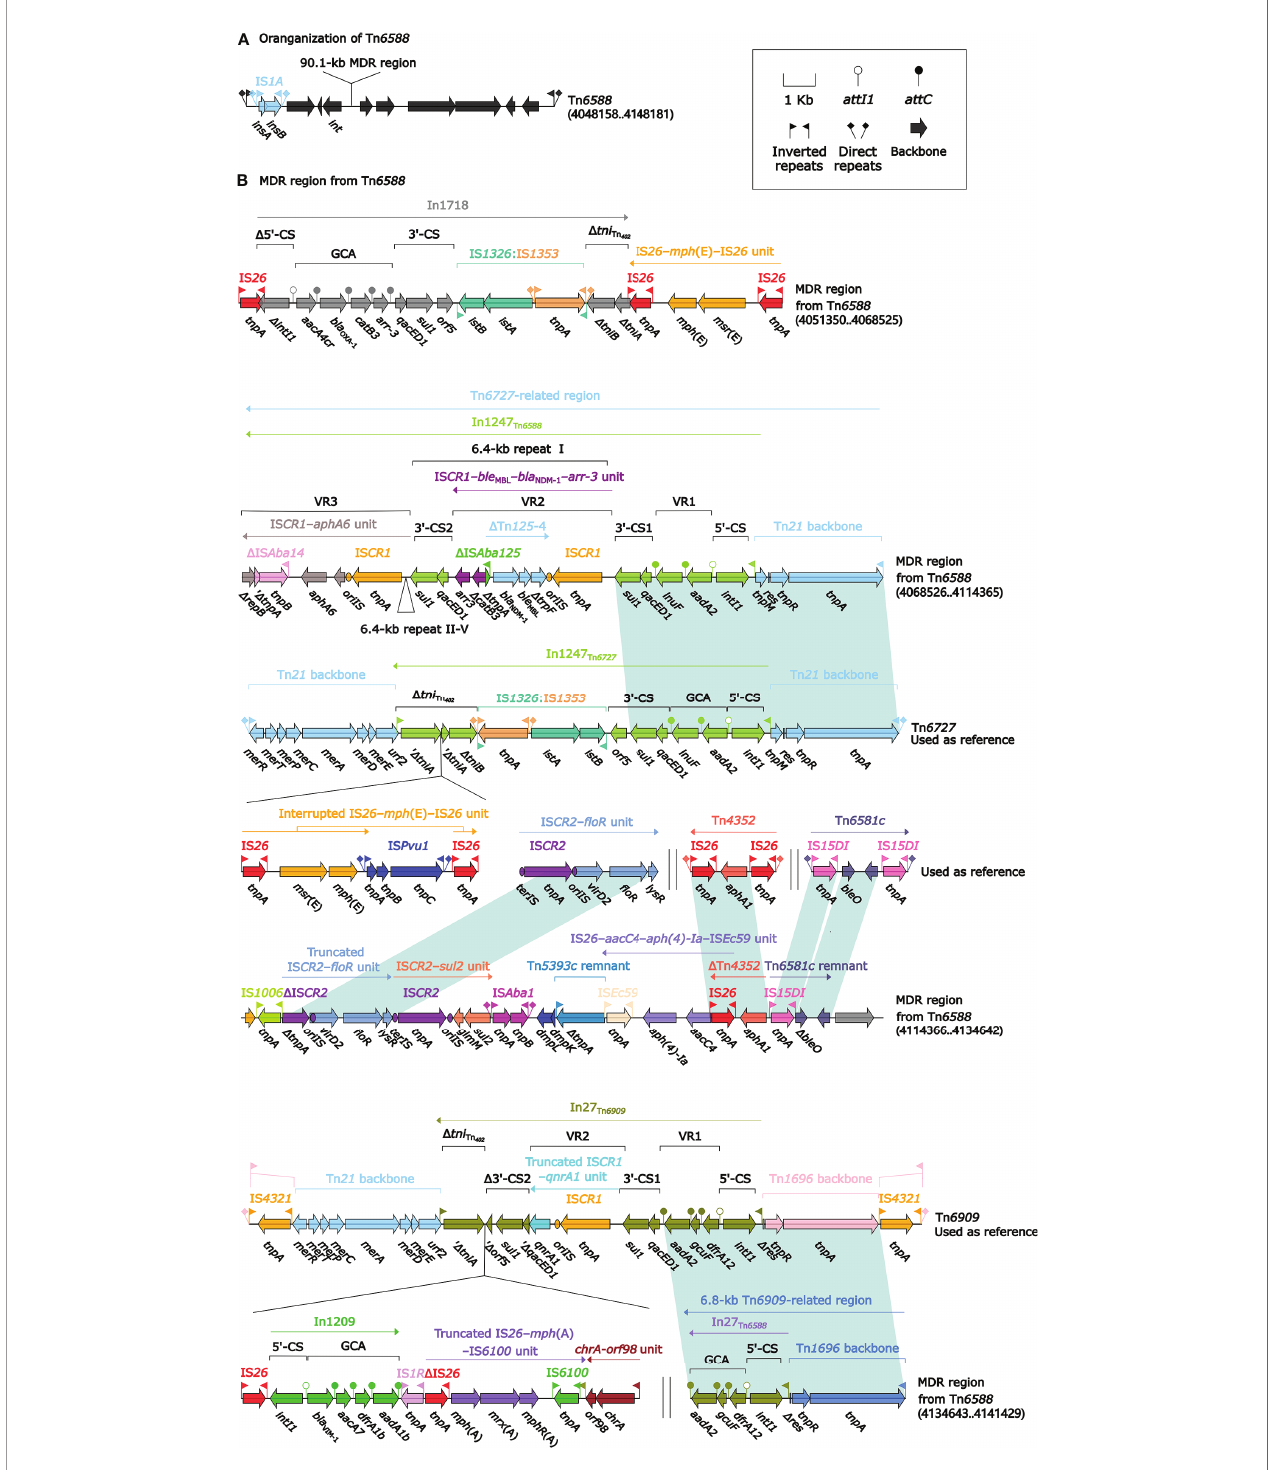
FIGURE 2 | Shown are the organization of Tn 6588 (A) , and MDR region from Tn 6588 (B) . Genes are denoted by arrows. Genes, mobile elements, and other features are colored based on their functional classi fi cation. Shading denotes regions of homology (nucleotide identity ≥ 95%). Numbers in brackets indicate nucleotide positions within the chromosome of strain 1701091. The accession numbers of Tn 6727 , IS CR2 – fl oR unit, Tn 4352 (Wrighton and Strike, 1987), Tn 6581c , and Tn 6909 used as reference are CP047346, CP042857, CP042858, CP042857, and CP032168, respectively.